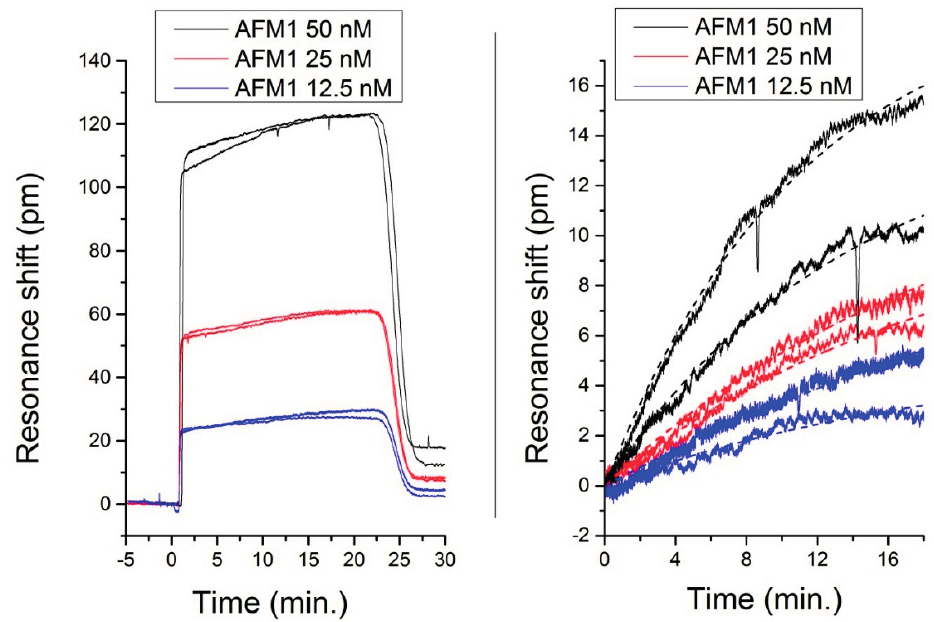
Figure 9. ( Left ) Sensorgram recorded using a sample from the L2 wafer in TM polarization. The high step-like response is due to the refractive index mismatch produced by the small content of Dimethyl sulfoxide (DMSO) in the solution. This solvent is needed to dissolve the AFM1 in the buffer solution; ( Right ) Specific binding sensorgrams obtained from the curves in ( Left ) by subtracting the bulk shift induced by the DMSO content. The dashed curves are exponential fittings for the evaluation of the rate constants and of the initial slopes